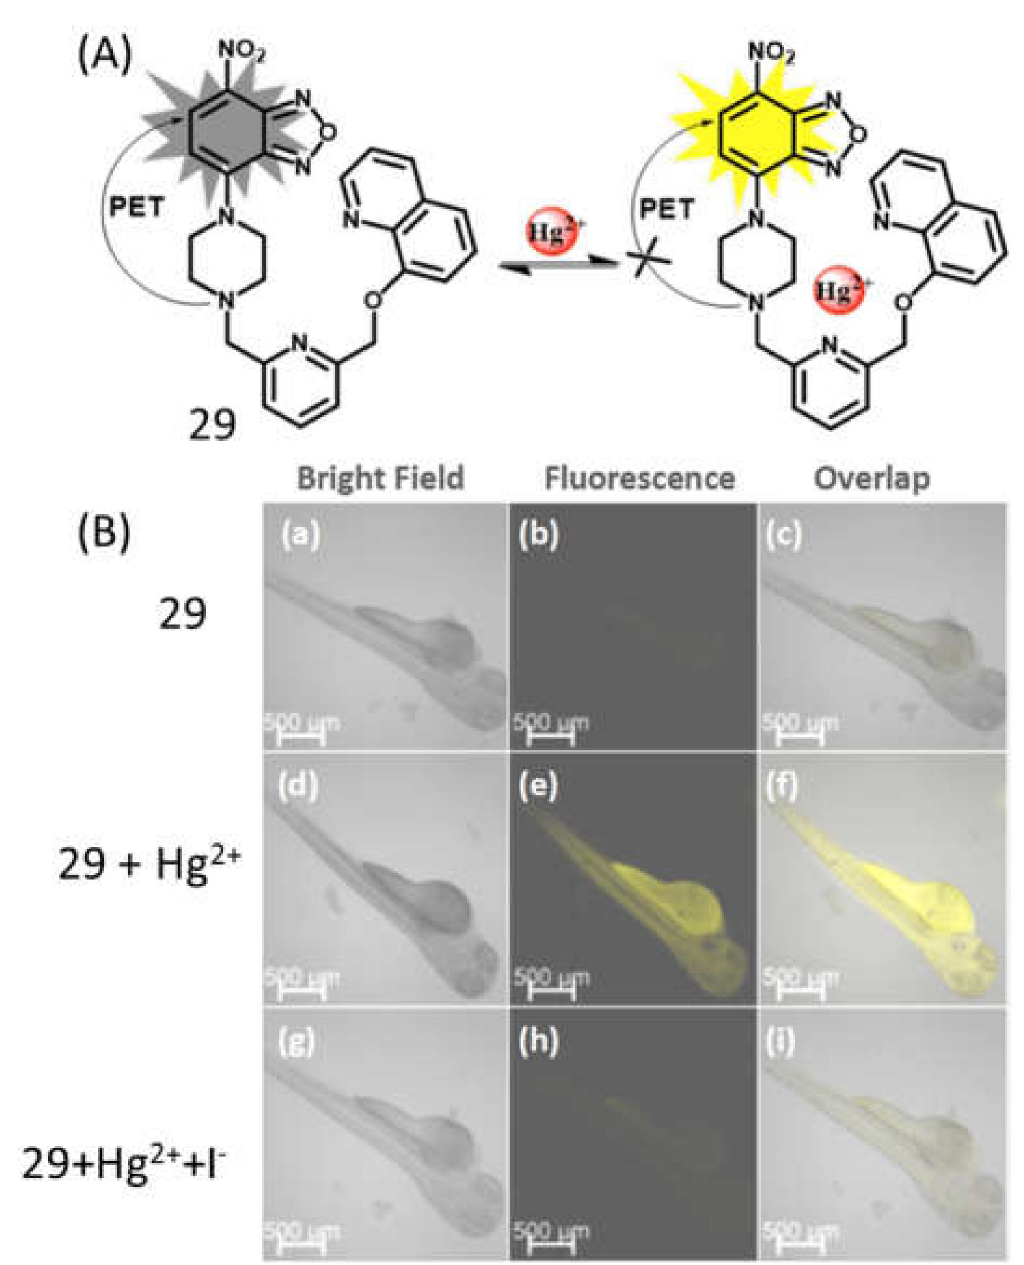
Figure 12. ( A ) Proposed binding mode and responding mechanism of 29 with Hg 2+ . ( B ) Fluorescence images of three-day- old zebrafish incubated with 29 (20 µ M) at 28 ◦ C for 30 min ( a – c ), subsequent treatment with Hg 2+ (40 µ M) for 30 min ( d – f ) and further incubation with I − (40 µ M) for 30 min ( g – i ). λ ex = 488 nm; yellow channel: λ em = 500–600 nm; scale bar: 500 µ m. Reproduced with permission from [59]. Copyright 2020